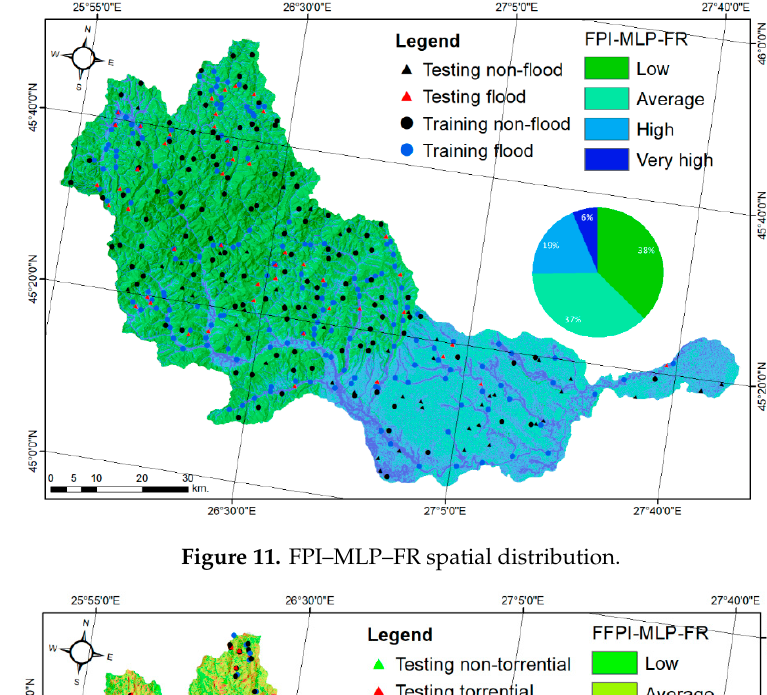
Water 2019 , 11 , x FOR PEER REVIEW Figure 11. FPI–MLP–FR spatial distribution. Figure 11. FPI–MLP–FR spatial distribution.